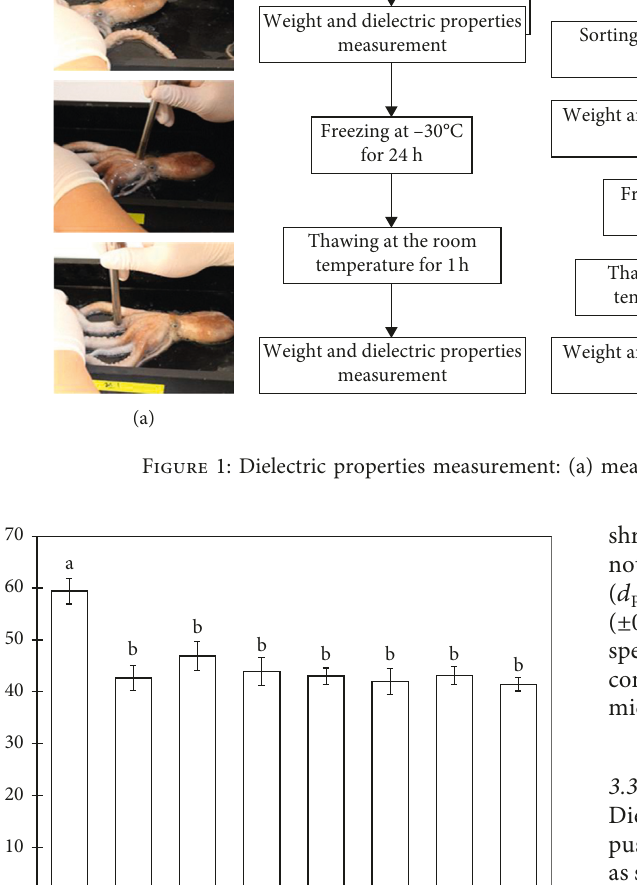
electric properties measurement was 168.43 ( ± 80.33) g.